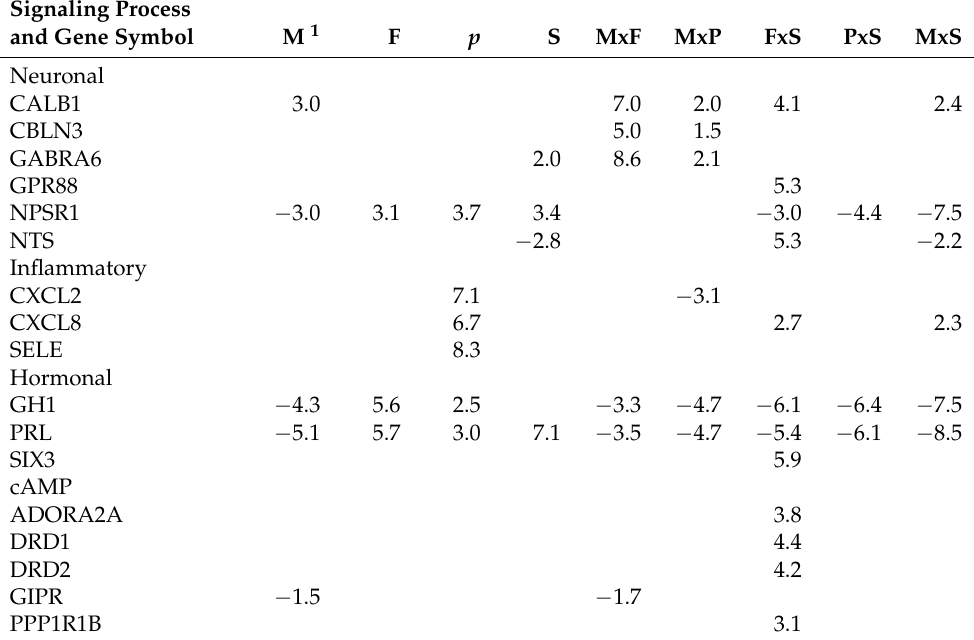
Table 3. Log 2 (fold change) of differentially expressed (FDR-adjusted p -value < 0.05) genes in at least one interaction (x) or main effect of maternal immune activation (M), postnatal stressor of fasting (F) or Poly(I:C) ( p ), or sex (S) that are annotated to inflammatory (I), neural (N), and hormonal (H) functional categories in the